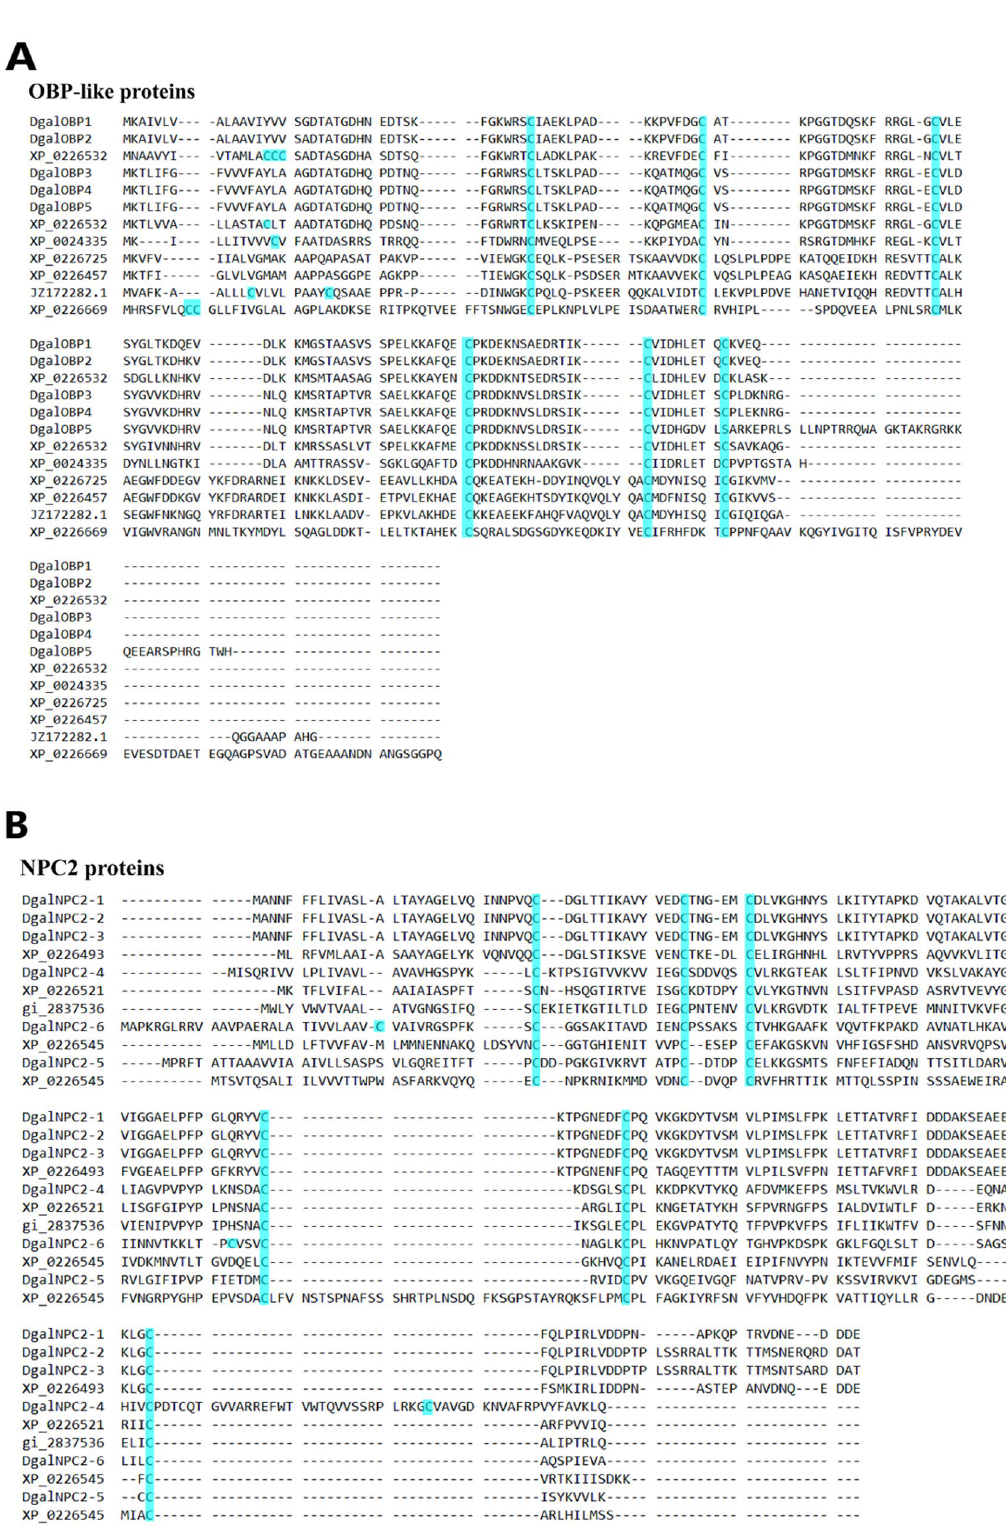
Figure 5. Alignment of the putative OBP-like and NPC2 sequences of PRM together with reference sequences. ( A ) Alignment of the five putative OBP-like sequences of PRM together with those of V . destructor sequences (XP_022653281.1; XP_022653293.1; XP_022645714.1; XP_022666940.1; XP_022672530.1), Amblyomma americanum (JZ172282.1) and Ixodes scapularis (XP_002433530.1). The highly conserved six cysteine ( C ) residues are shown in blue. ( B ) Alignment of the six putative NPC2 sequences of PRM together with those of V . destructor sequences. The highly conserved six cysteine ( C ) residues are shown in